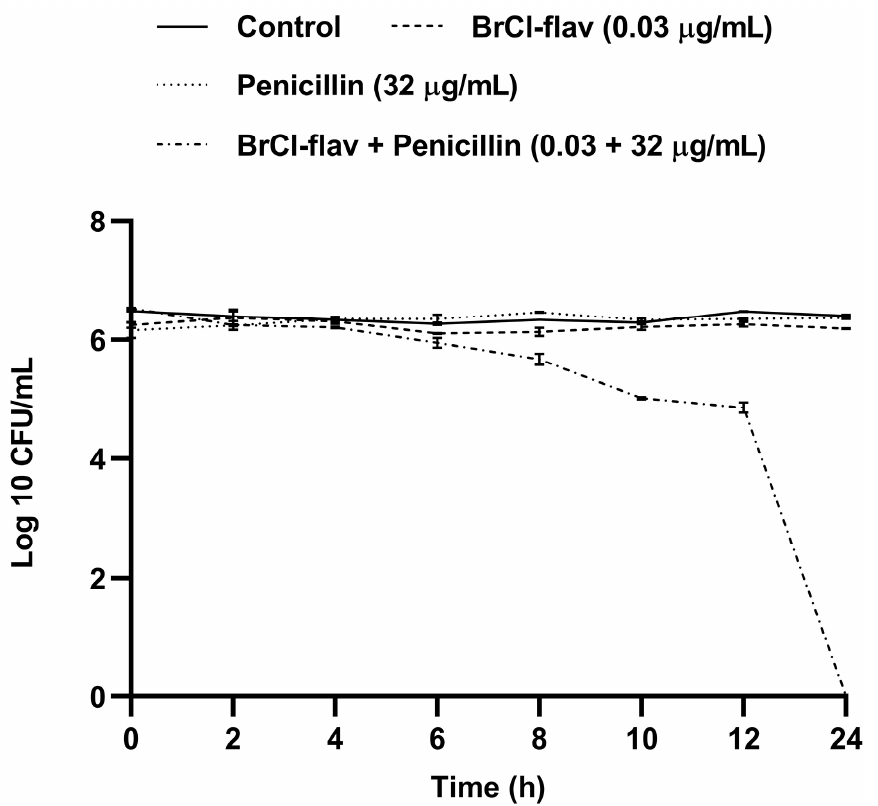
Figure 8. The time-kill curve of BrCl-flav and penicillin synergistic combination against an MRSA isolate. Values are the means of three replicates. Bars indicate SEM.